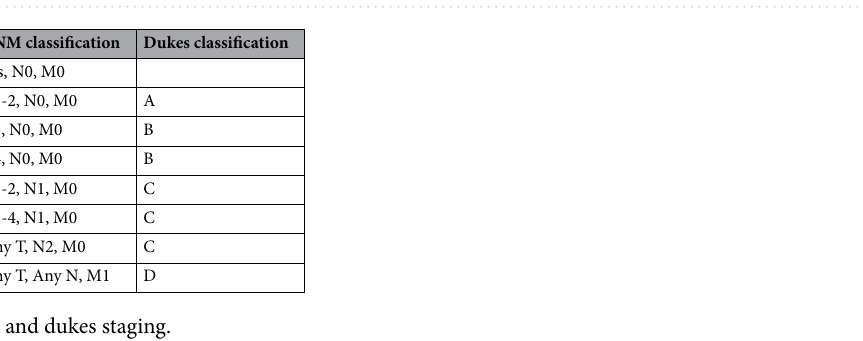
Figure 3. Association between colonic tumour location (right sided vs left sided) and emergency presentation—Forest Plot.